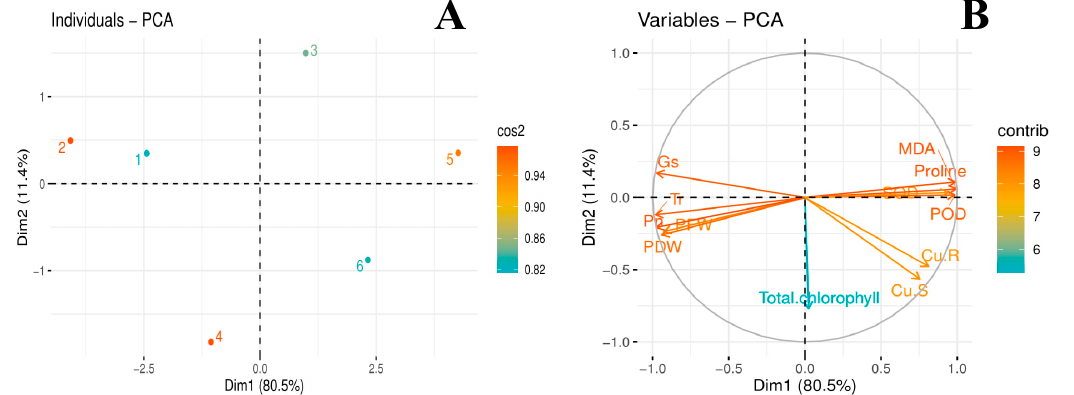
Figure 6. Score ( A ) and loading plot ( B ) of principal component analysis (PCA) on different studied attributes of C. capsularis seedlings plants supplemented with citric acid (CA) while grown under Cu stress. Score plot represents separation of treatments as (1) Cu 0 CA 0 (Cu = 0 μ M and CA = 0 mM), (2) Cu 0 CA 1 (Cu = 0 μ M and CA = 2 mM), (3) Cu 1 CA 0 (Cu = 50 μ M and CA = 0 mM), (4) Cu 1 CA 1 (Cu = 50 μ M and CA = 2 mM), (5) Cu 2 CA 0 (Cu = 100 μ M and CA = 0 mM) and (6) Cu 2 CA 1 (Cu = 100 μ M and CA = 2 mM). The abbreviations are as follows: PFW: plant fresh weight; PDW: plant dry weight; MDA: